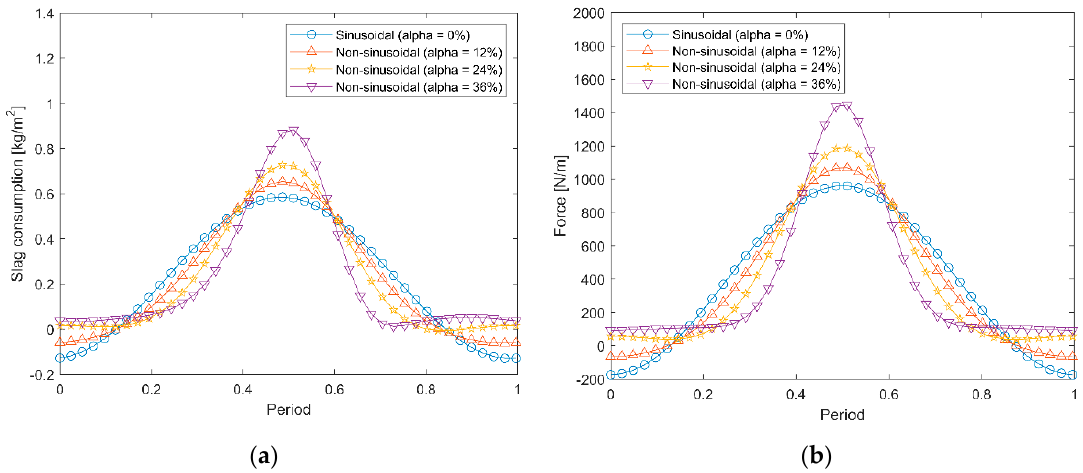
Figure 13. ( a ) Transient slag consumption Q lub and ( b ) force profiles from slag pressure with different modification factors α during the oscillation